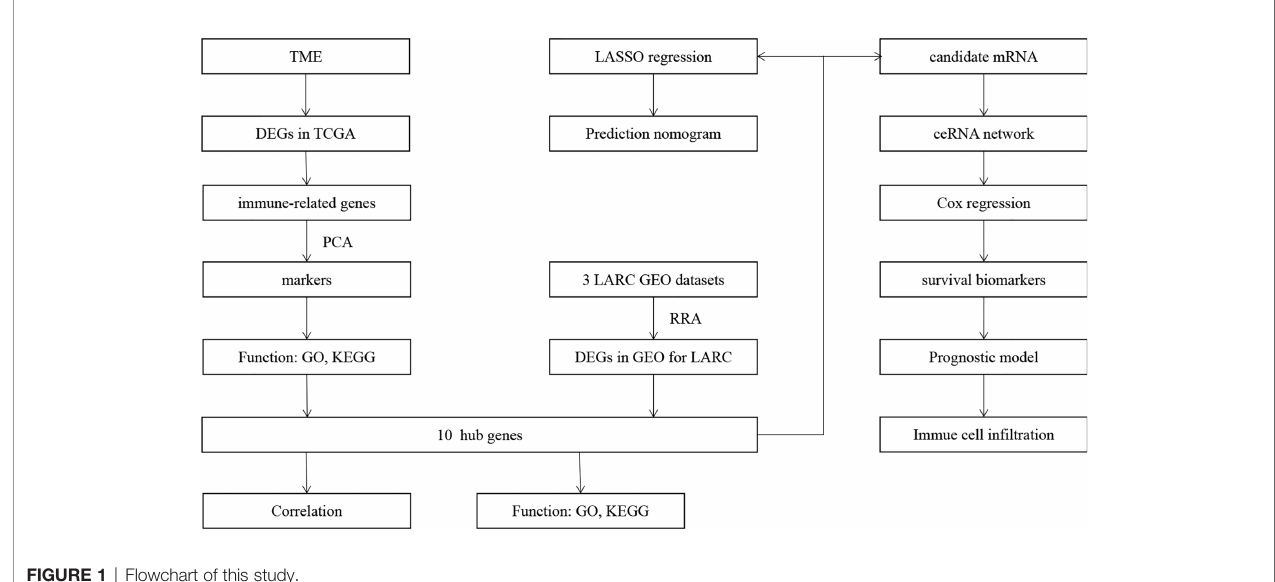
FIGURE 1 | Flowchart of this study.